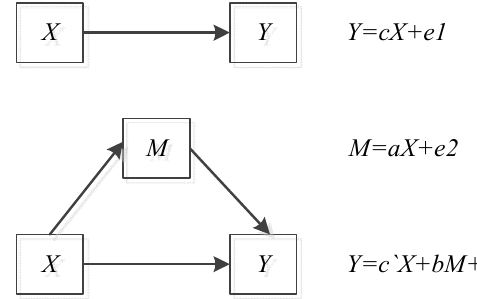
Figure 1. Relationship of X , Y and M .